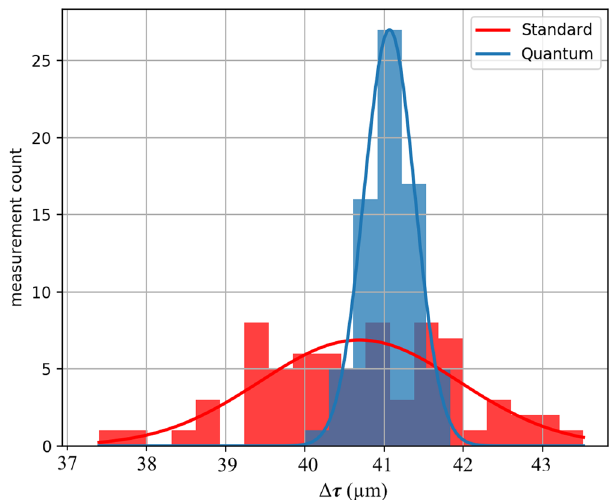
Fig. 4 Histogram of inferred index difference after 70 repetitions with the same two-core fi ber for both standard (red) and quantum-enhanced (blue) measurements. Fits to the data assumed a normal